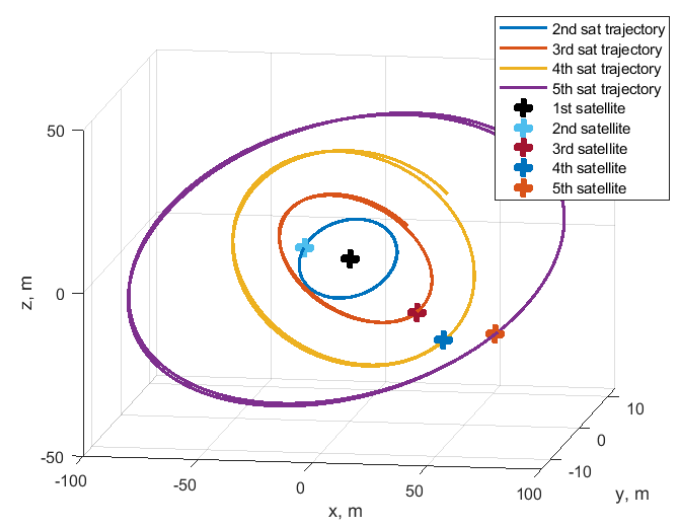
Figure 25. Relative trajectories during the last 2 h of simulation.